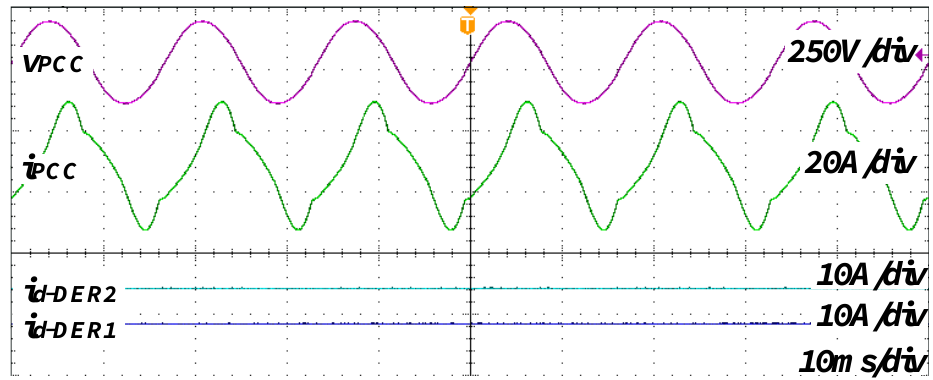
Figure 9. Experimental result: single-phase MG operating with all loads connected and with DERs disabled. From top to bottom: PCC voltage and current, d-DER 2 and d-DER 1